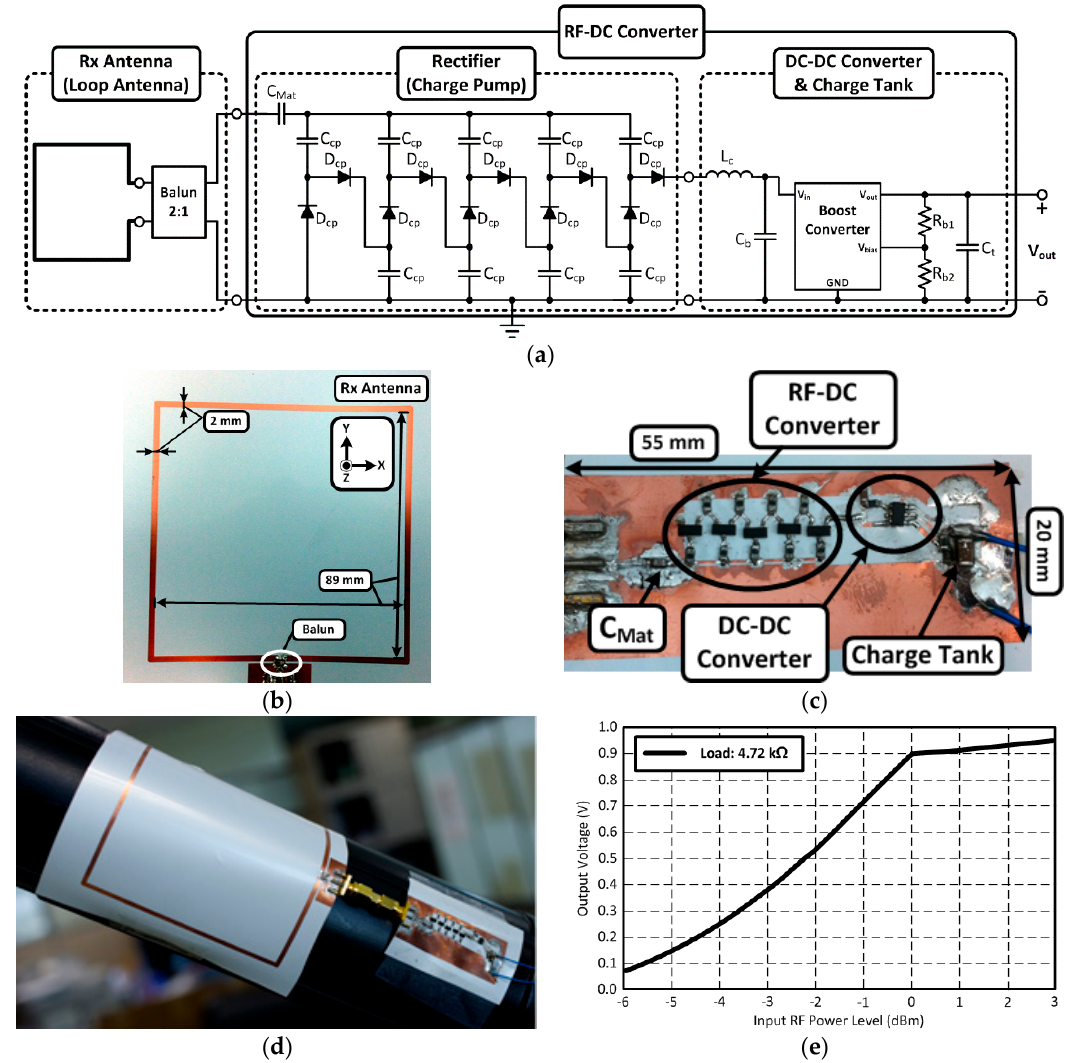
Figure 16. Far-field radio frequency (RF) energy harvesting system for a self-sustainable wireless sensor platform utilizing the hybrid printed electronic technology: ( a ) Circuit schematics; ( b ) square loop antenna; ( c ) RF-DC converter with a boost DC-DC converter, and the flexibility of the proposed hybrid printed RF energy harvester; ( d ) flexibility of the fabricated antenna and RF-DC converter; and ( e ) measured output voltage on a 4.72 k Ω load.